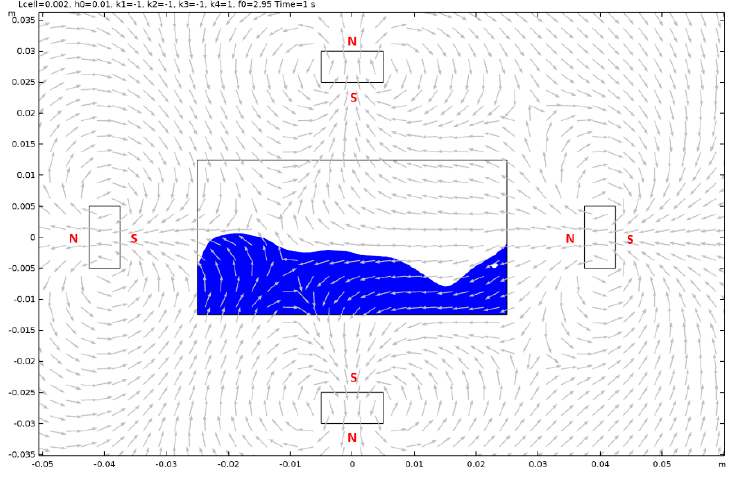
29 of 37 Figure A14. Case 15.